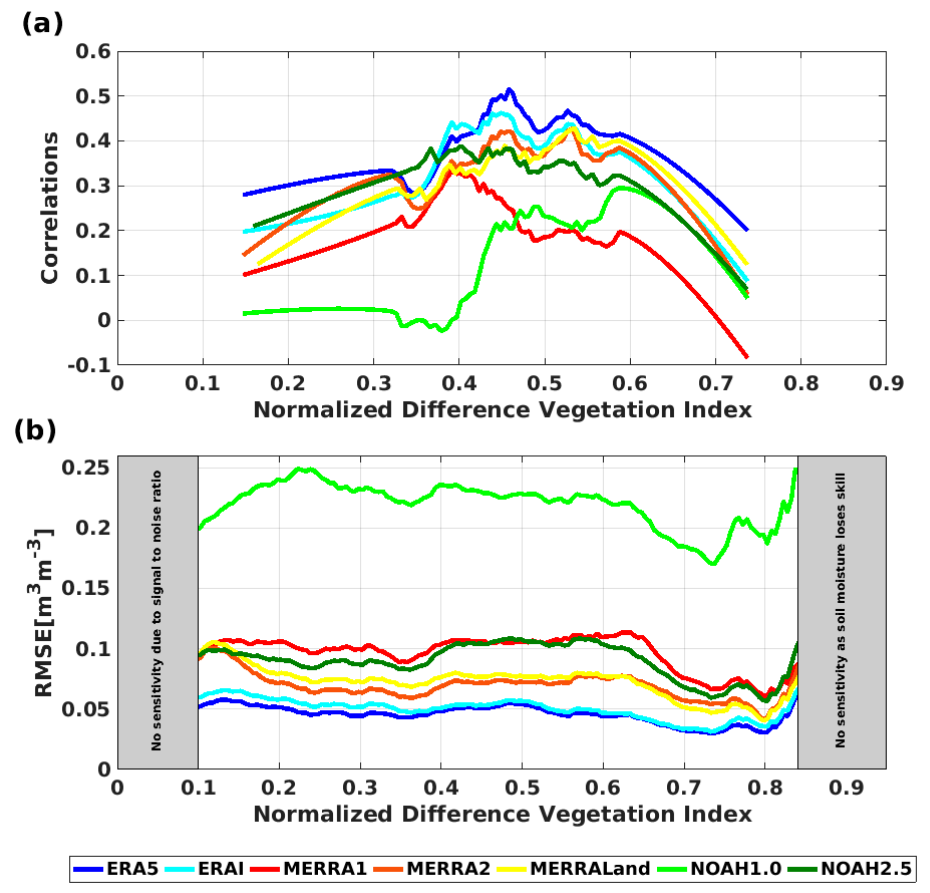
Figure 2. ( a ) Validation results for correlation analysis with in situ datasets and ( b ) Root mean square error (RMSE) results from the triple collocation analysis as a function vegetation density from the normalized difference vegetation index.